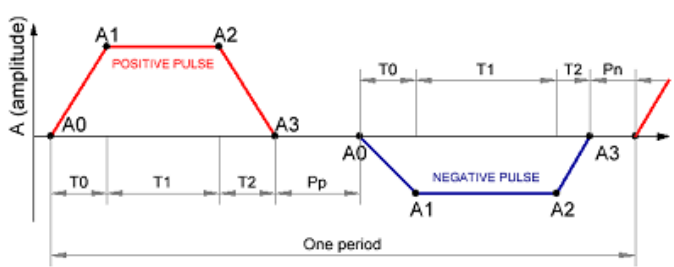
Figure 9. Sketch of the trapezoidal pulse waveform and corresponding parameters.